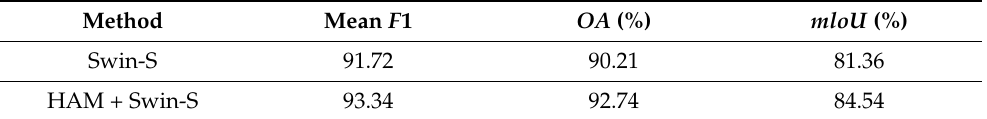
Table 3. Ablation study. The swin-transformer [8] with or without HAM. HAM denotes our proposed hierarchical aggregation module (HAM).